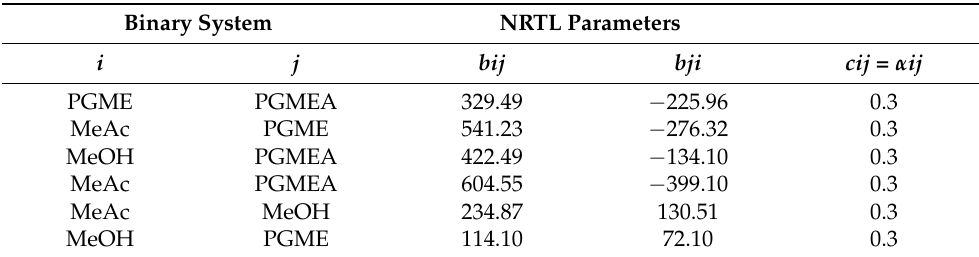
Table 1. Binary system and NRTL binary parameters (R = 8.314 J/mol ·